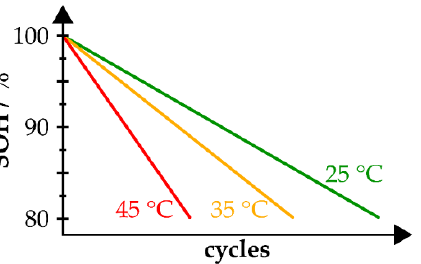
Figure 1. Simplified capacity fade of a typical Li-ion battery vs. number of cycles for different operating temperatures.